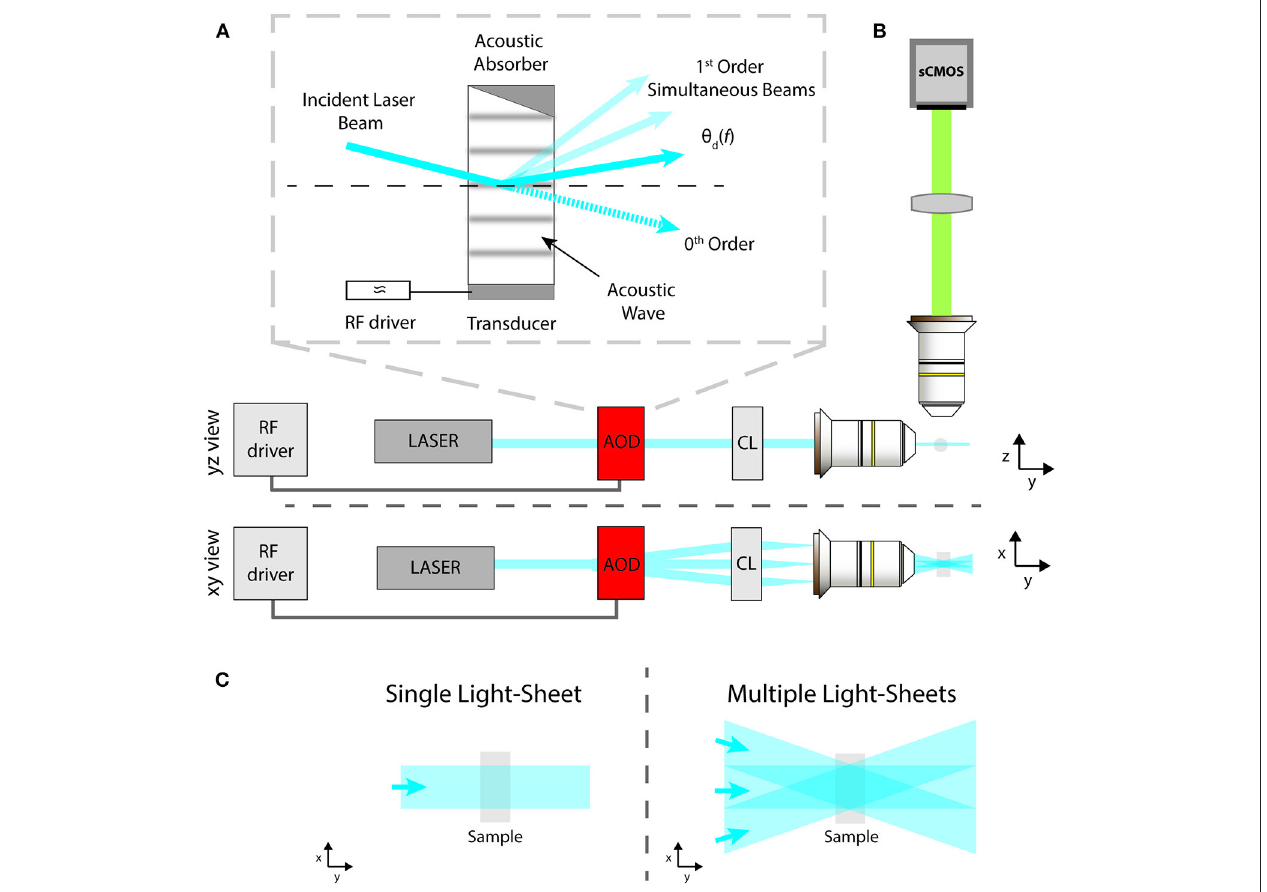
FIGURE 1 | Schematic of: (A) the AOD operation principle; (B) the LSFM excitation and imaging paths from side and top views; (C) standard sample illumination with a single light-sheet or with multiple ones coming from different angles to reduce striping defects.